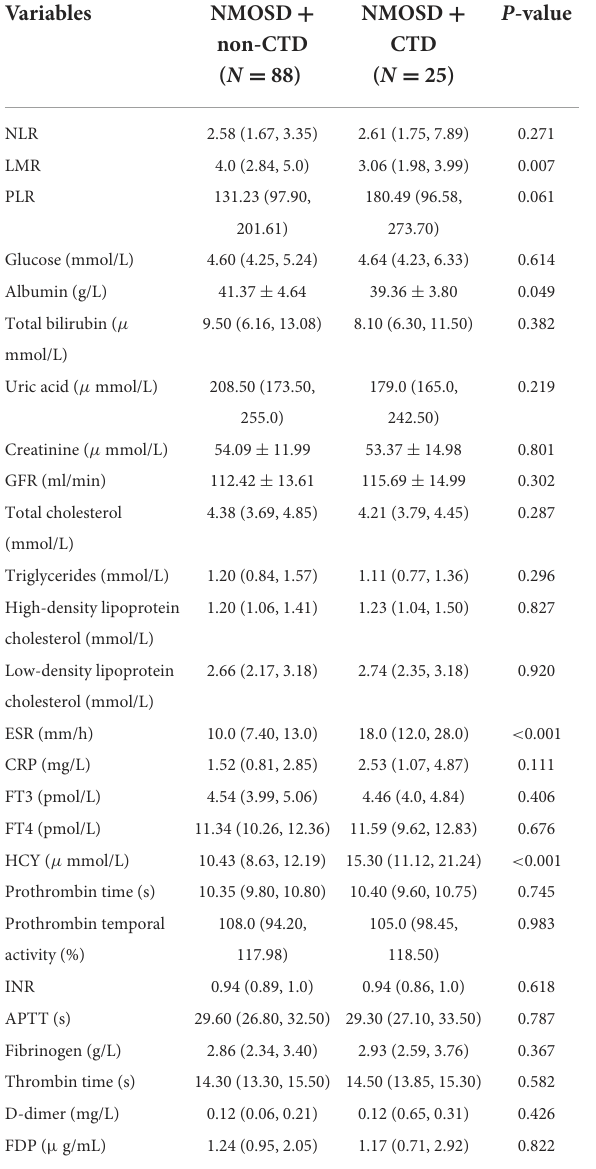
TABLE 5 MRI findings in patients of first-attack NMOSD with and without